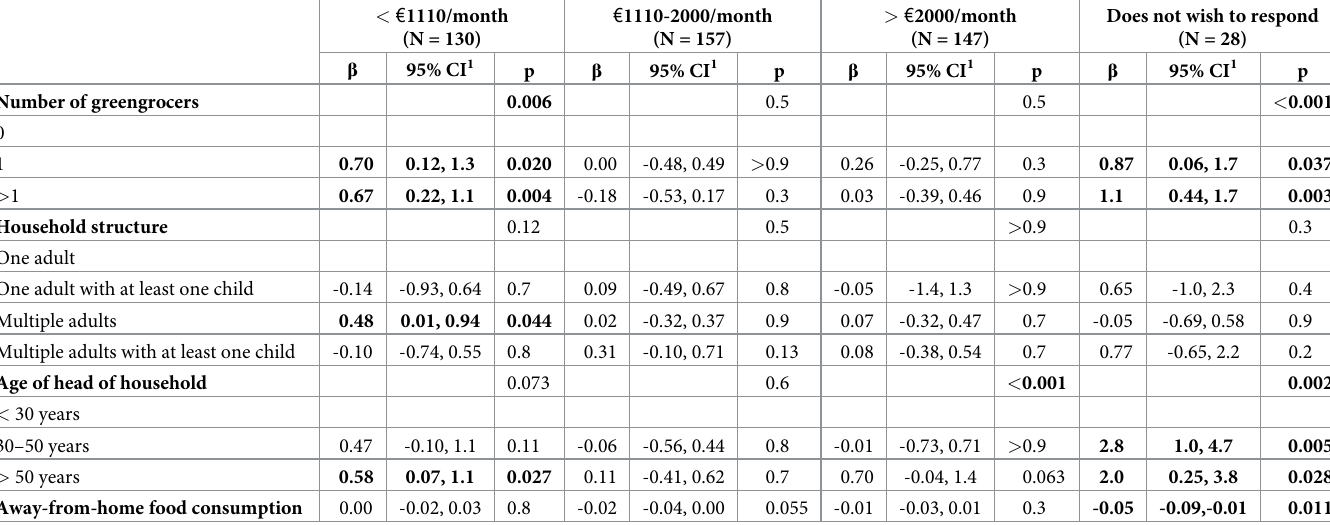
Table 4. Adjusted multilevel model (stratified by income level) of the associations between number of food outlets and activity space and nutritional quality of food purchases (r-HPI z-score) (N = 462). < € 1110/month (N = 130)